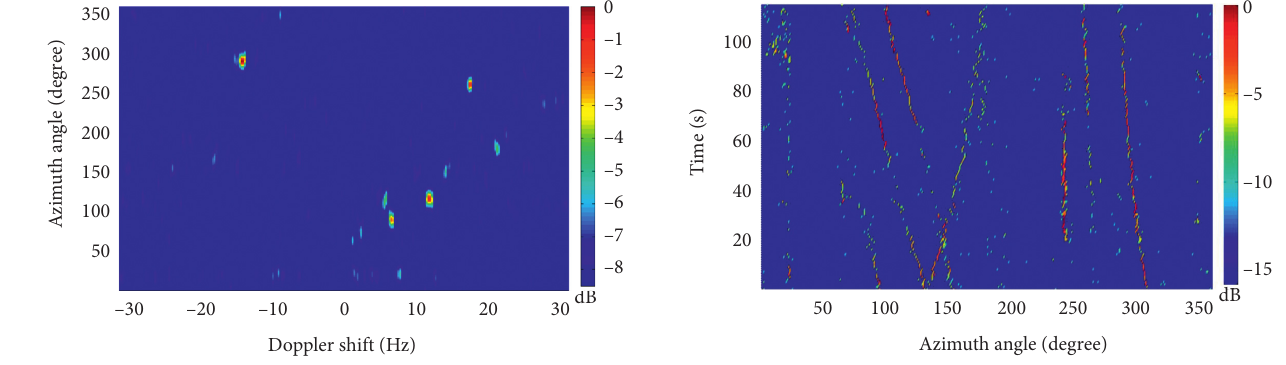
Figure 3: Azimuth-doppler map at t � 80.